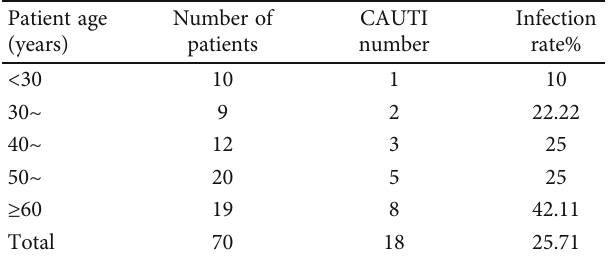
Table 1: The in fl uence of patient age distribution on